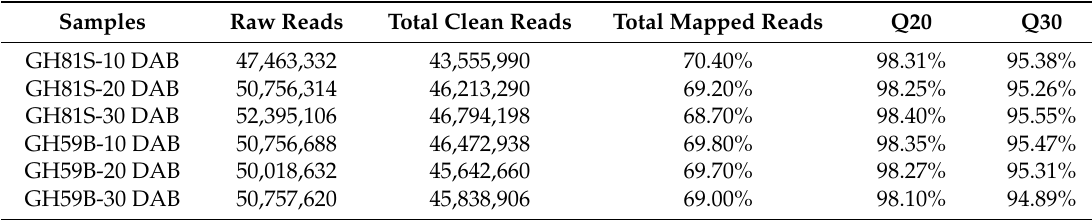
Table 1. Statistics of the reads in the present